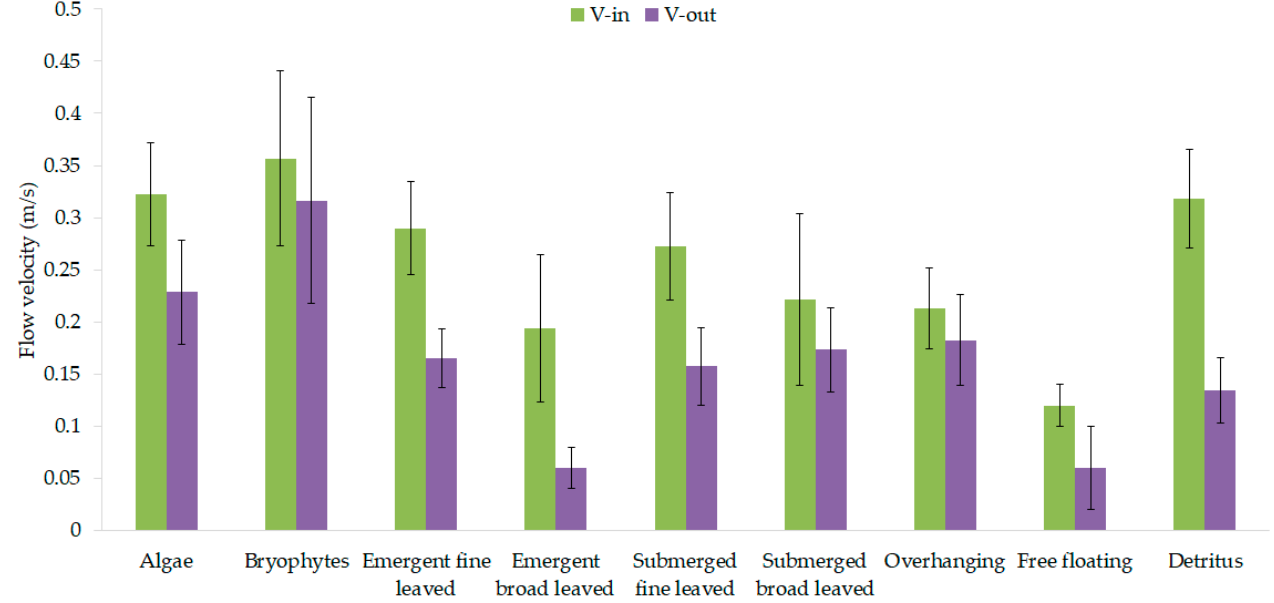
Figure 3. Average (±standard error) flow velocity before (V-in; m/s) and after (V-out; m/s) each vegetation type.